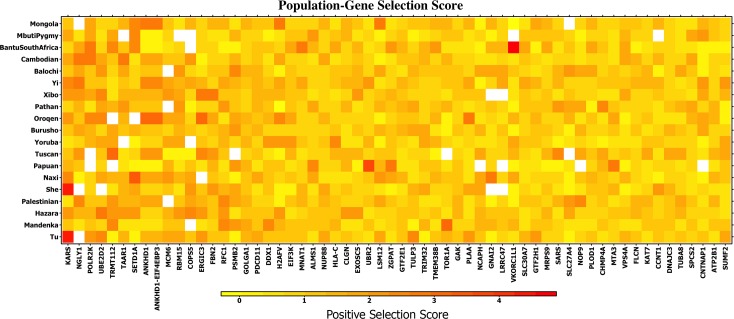
Genes that interact with HIV-1 under selection.The genes are sorted from left to right by highest to lowest mean selection across the 19 populations exhibiting a p-value < 0.1 for selection associated with HIV-1. The cumulative effect of a moderate selection signal allows for the detection of positive selection in these genes. The top 3 genes are KARS, NGLY1, and POLR2K (leftmost on the axis) are known inhibit HIV-1 replication.